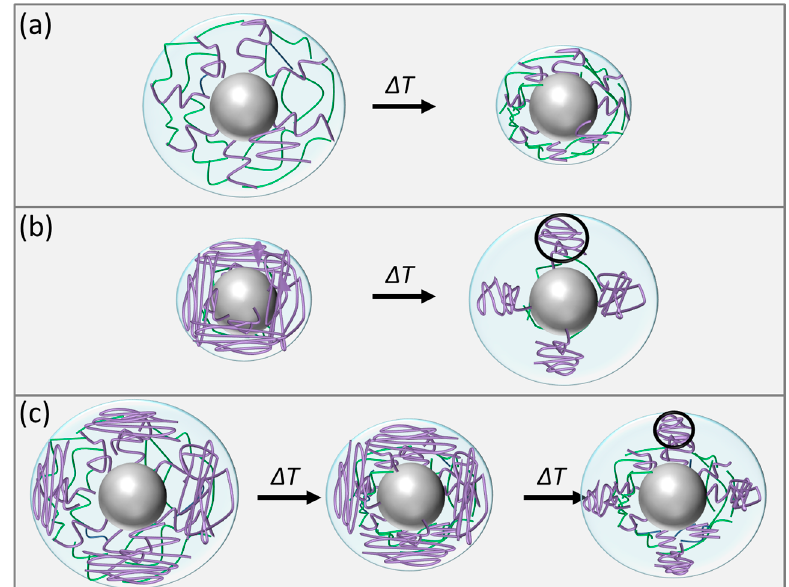
Figure 6. Different scenarios for the core-shell particles during the coil-to-globule transition. The silica core is shown as a grey sphere. The poly-( N -isopropyl acrylamide) (pNipam) chains are represented in purple and the crosslinking chains between two pNipam chains are visualized in green. The light blue circles indicate the hydrodynamic volume of the particles. Scenario ( a ): Below the lower critical solution temperature (LCST): The microgel particle is swollen with water and the pNipam chains are elongated. The pNipam chains are crosslinked from the inner to the outer shell. Above the LCST the pNipam shell collapses. Due to the internal crosslinking the pNipam shell homogeneously shrinks and the pNipam shell gets thinner due to the expulsion of water. Scenario ( b ): Below the LCST the pNipam chains are elongated and linked to the silica surface. Only near the surface of the silica particles are the pNipam chains crosslinked. Therefore, above the LCST the pNipam chains collapse into small spheres onto the surface of the silica particles. These small spheres we call microgel balls—we highlighted one with a black circle. Scenario ( c ): Below the LCST the microgel is swollen with water and the pNipam chains are elongated. By increasing the temperature the microgel structure expels water and shrinks. Due to external crosslinking the shell gets thinner like in scenario ( a ). However, since long not-crosslinked pNipam chains are also presented, these pNipam chains show up as microgel balls on the surface.